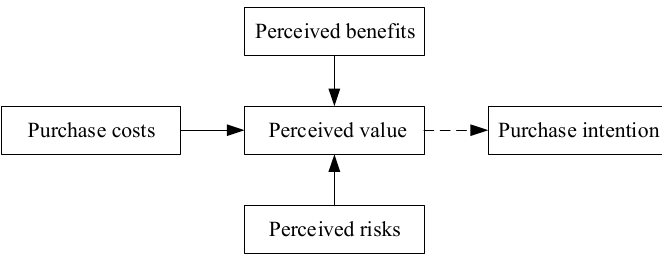
Figure 1. Preliminary theoretical research model based on PVT.